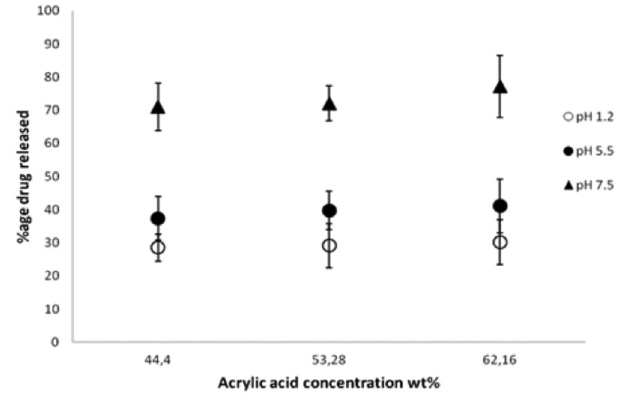
FIGURE 4 - Effect of acrylic acid concentration on tramadol HCl release after 12 h from PVP/AA copolymer with 0.3% MBA as cross-linking agent in solutions of pH 1.2 (o), 5.5 (●) and 7.5 (▲) at 37 °C.